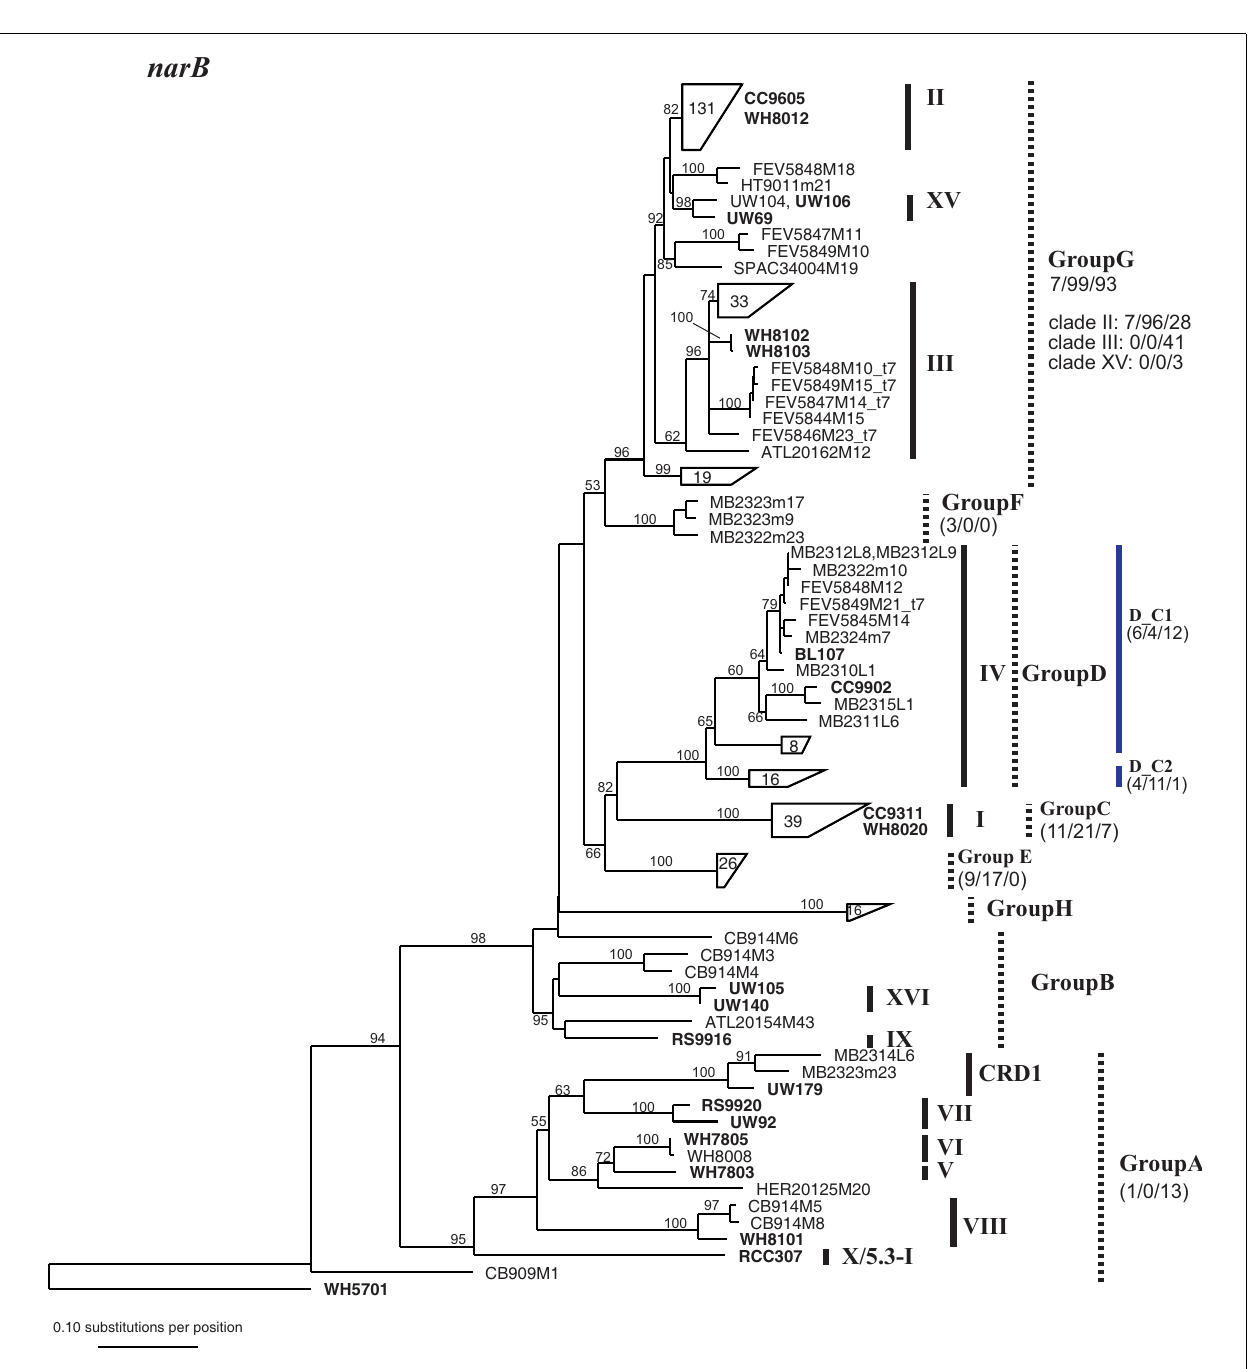
FIGUREA3 | Phylogenetic tree based on 648 nucleotide positions of the narB gene. Tree construction, bootstrap analysis, and taxa and clade labels as the same as described in FigureA1 . Because of the large number of sequences, selected sequences are grouped together and represented by trapezoids.The number inside the trapezoid indicates the number of sequences in that group. Strains within those groups that have been used in the concatenated tree ( FigureA6 ) are shown to the right of the trapezoids. The assignment of narB sequences to groups according to Paerl et al. (2011) is indicated with dashed lines. Group A, Group B, and Group G encompass